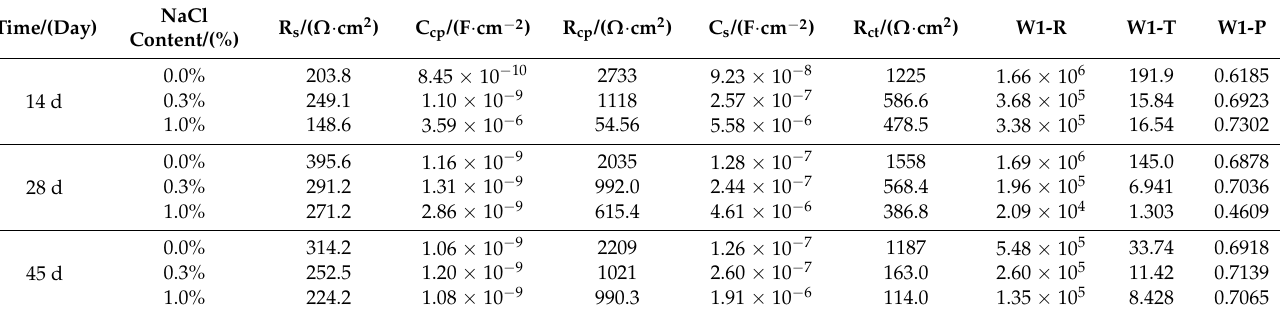
Figure 11. Equivalent circuit diagram of X70 steel in soil. Table 6. Equivalent circuit parameters of X70 steel in soil.